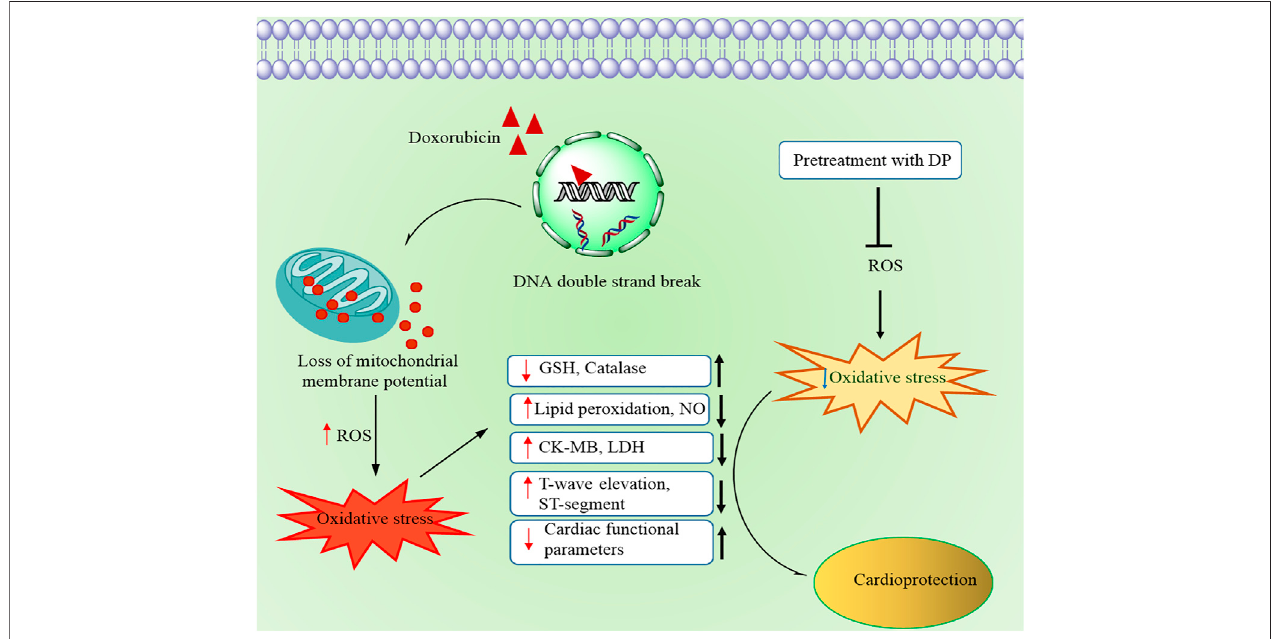
FIGURE 7 | Schematic representation of the proposed cardioprotective mechanism by the hydroalcoholic extract of DP